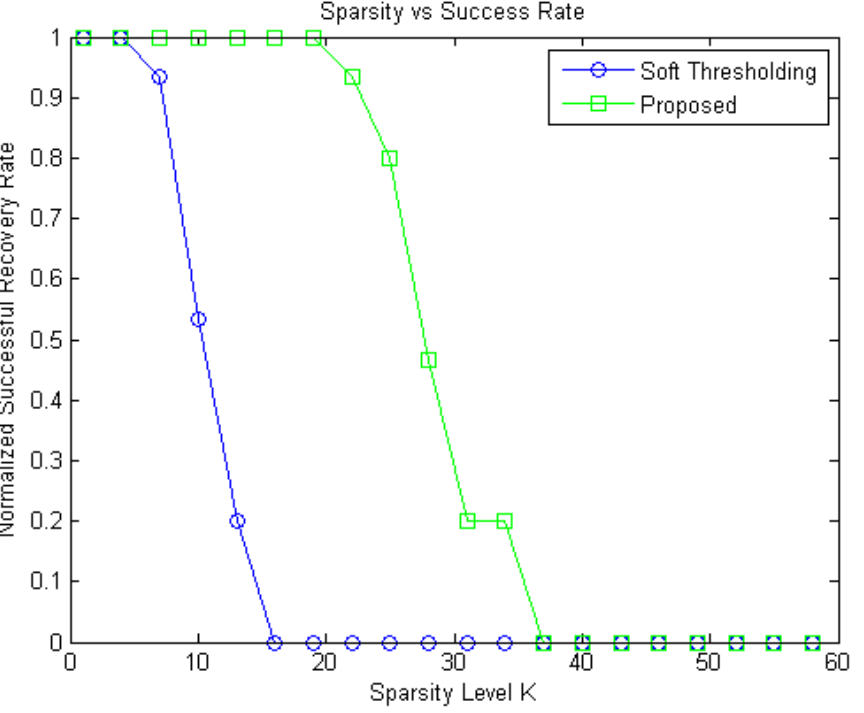
Figure 5. Fitness achieved by the soft thresholding and proposed algorithm. The proposed algorithm converges rapidly as compared to the soft thresholding technique.